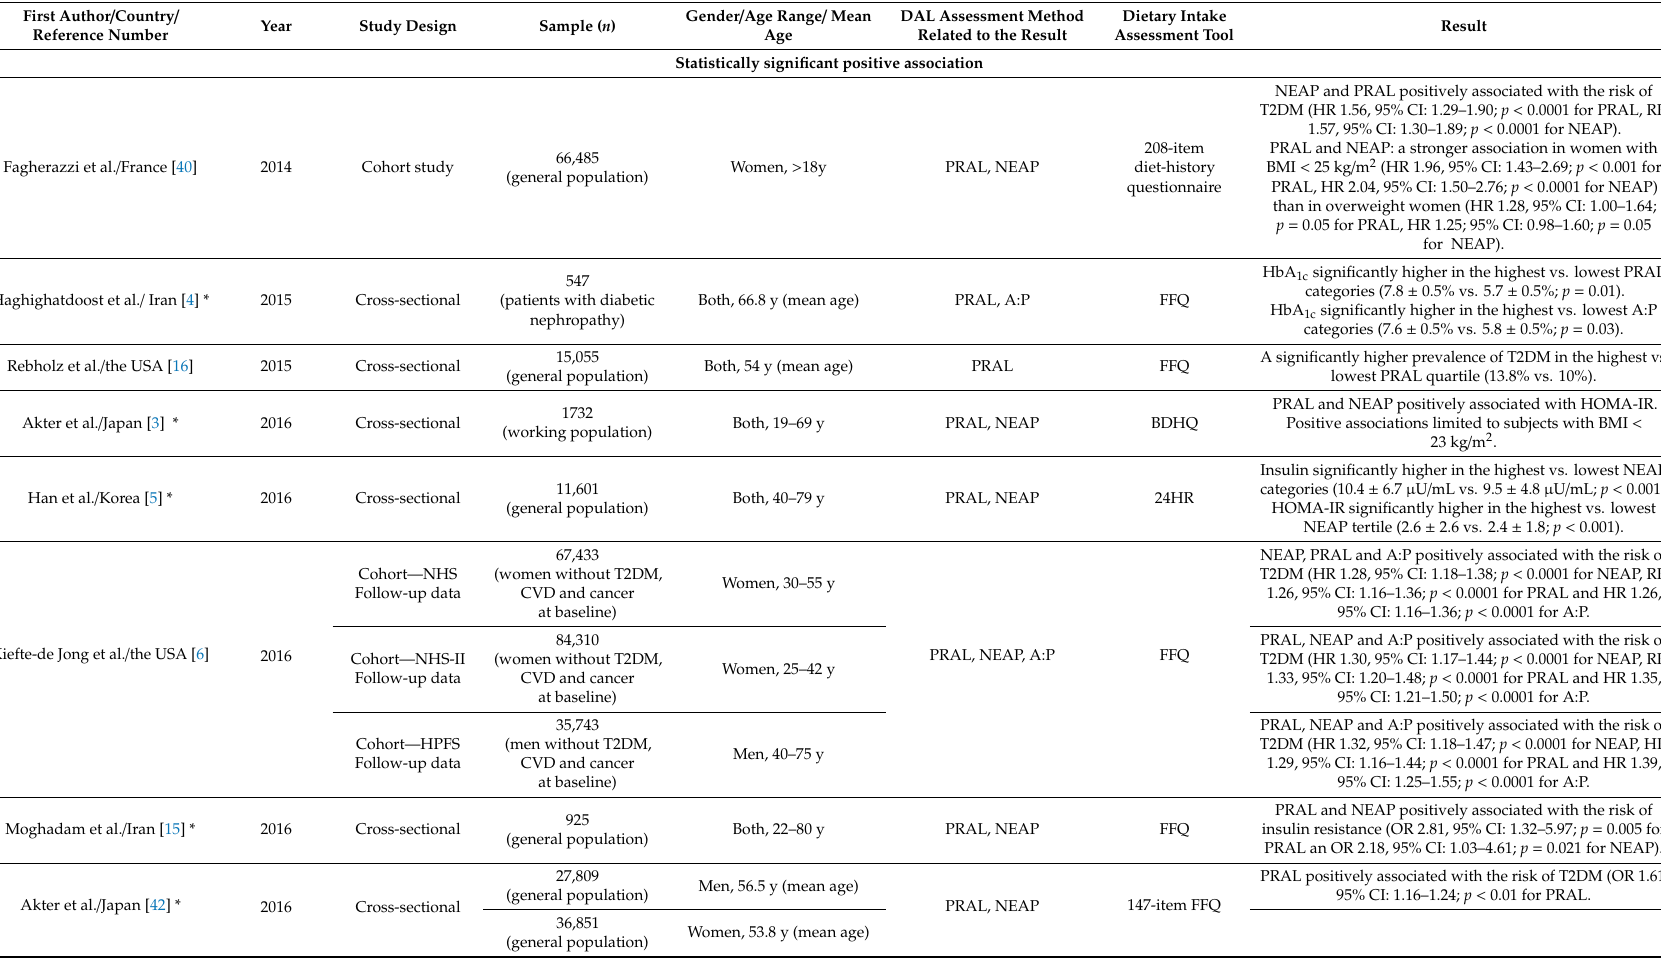
Table 2. Characteristics of studies referring to the association between DAL, fasting blood sugar, glycated hemoglobin (HbA1c), type 2 diabetes mellitus